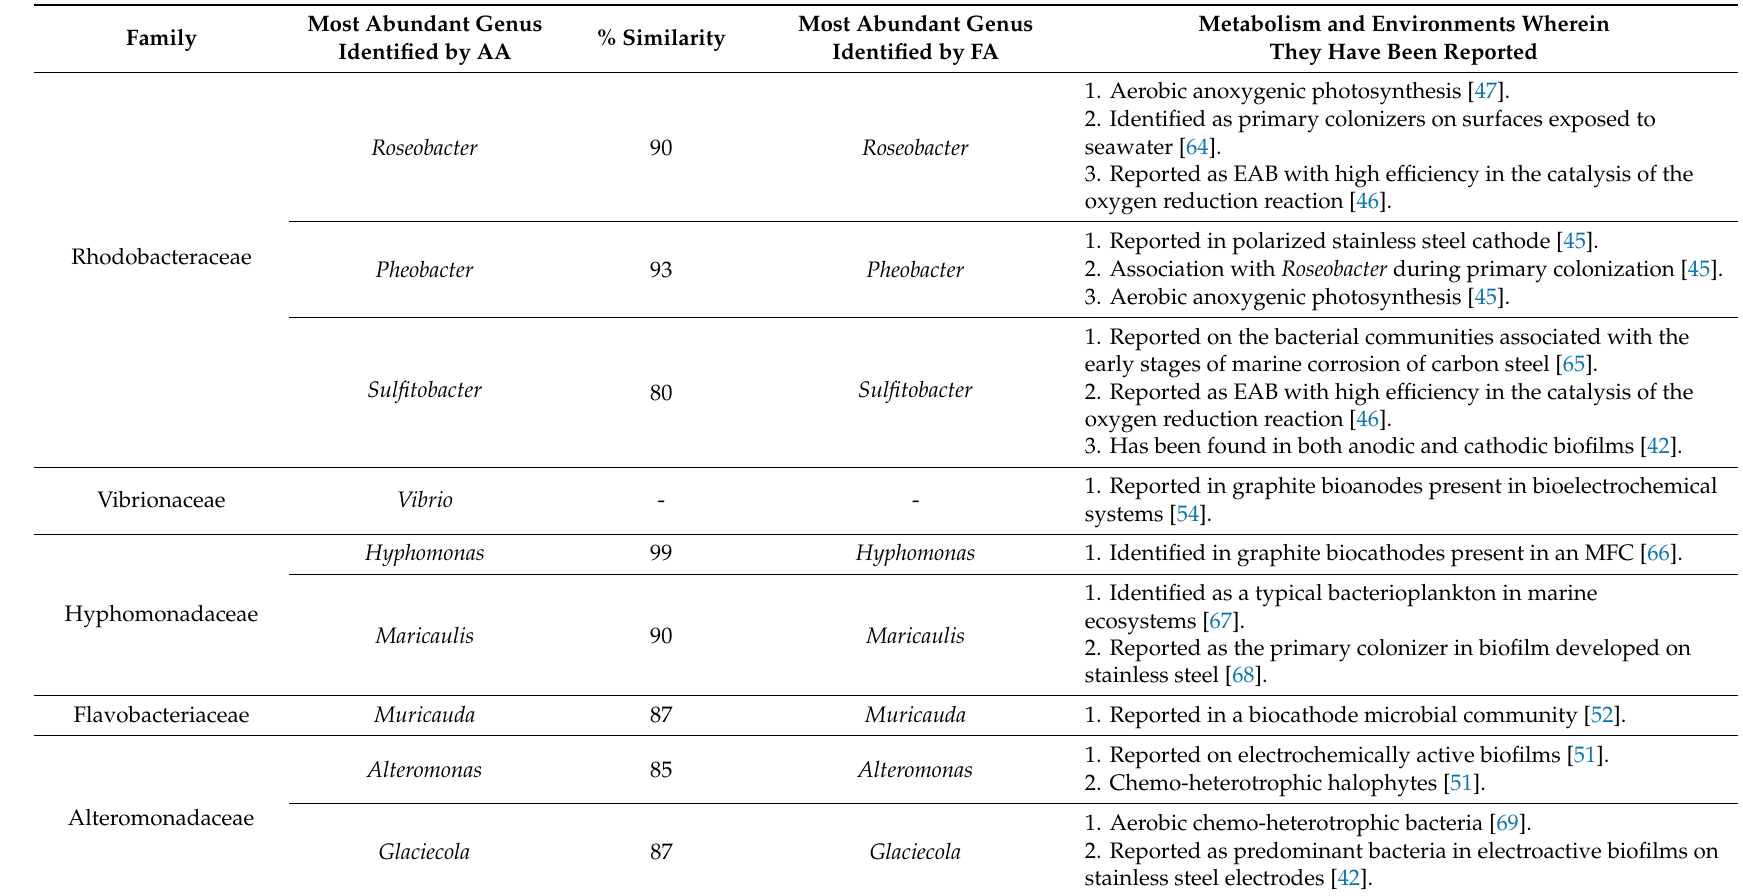
Table 2. Similarity analysis between sequences obtained by fragment analysis (FA) and amplicon analysis (AA), and their metabolisms and the environments wherein have been reported. The similarity between sequences obtained by AA and FA is expressed as %